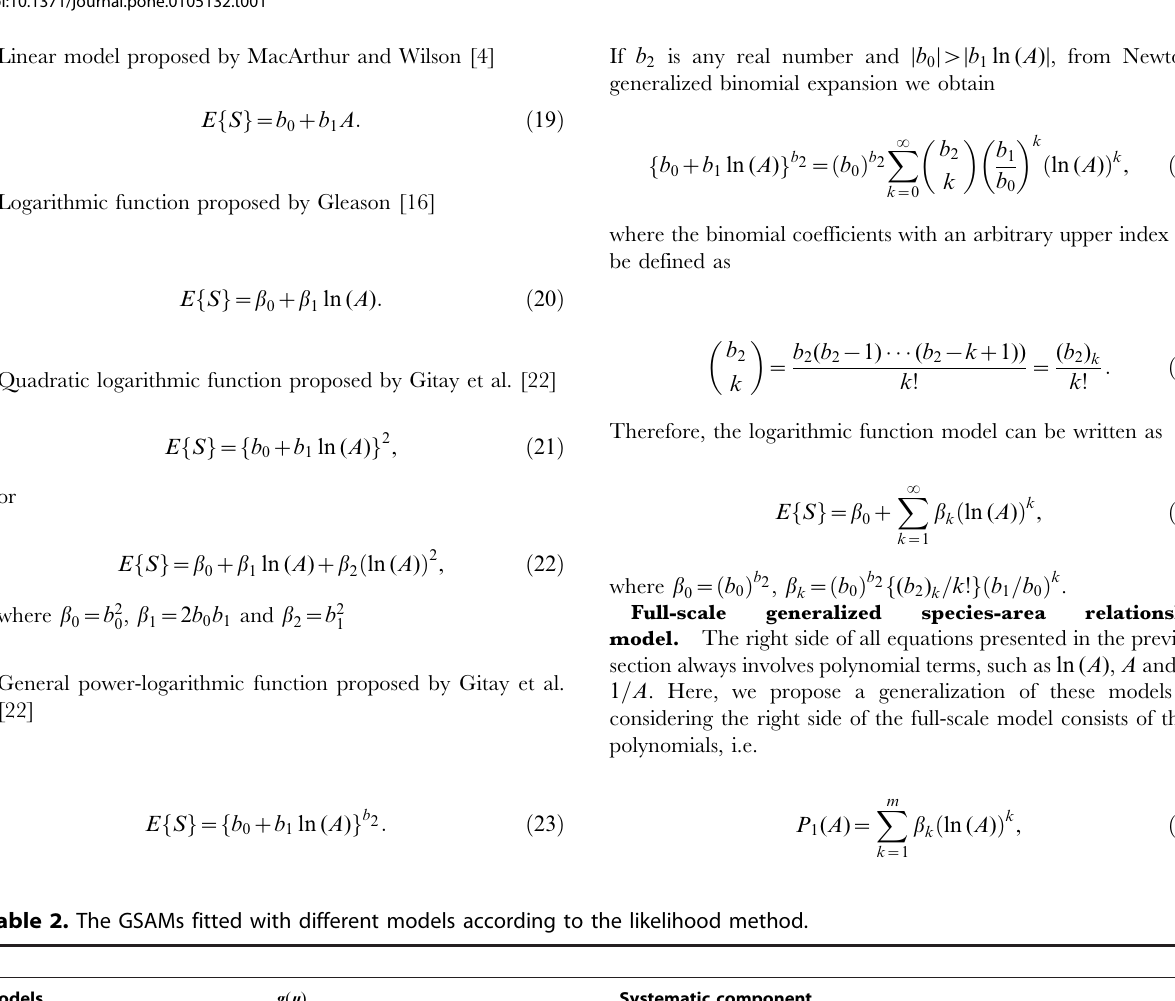
Selection Criteria